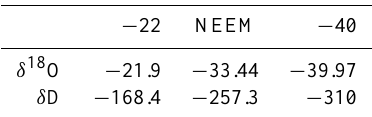
Table 1. Isotopic composition of the standards used for the VS- MOW calibrations in